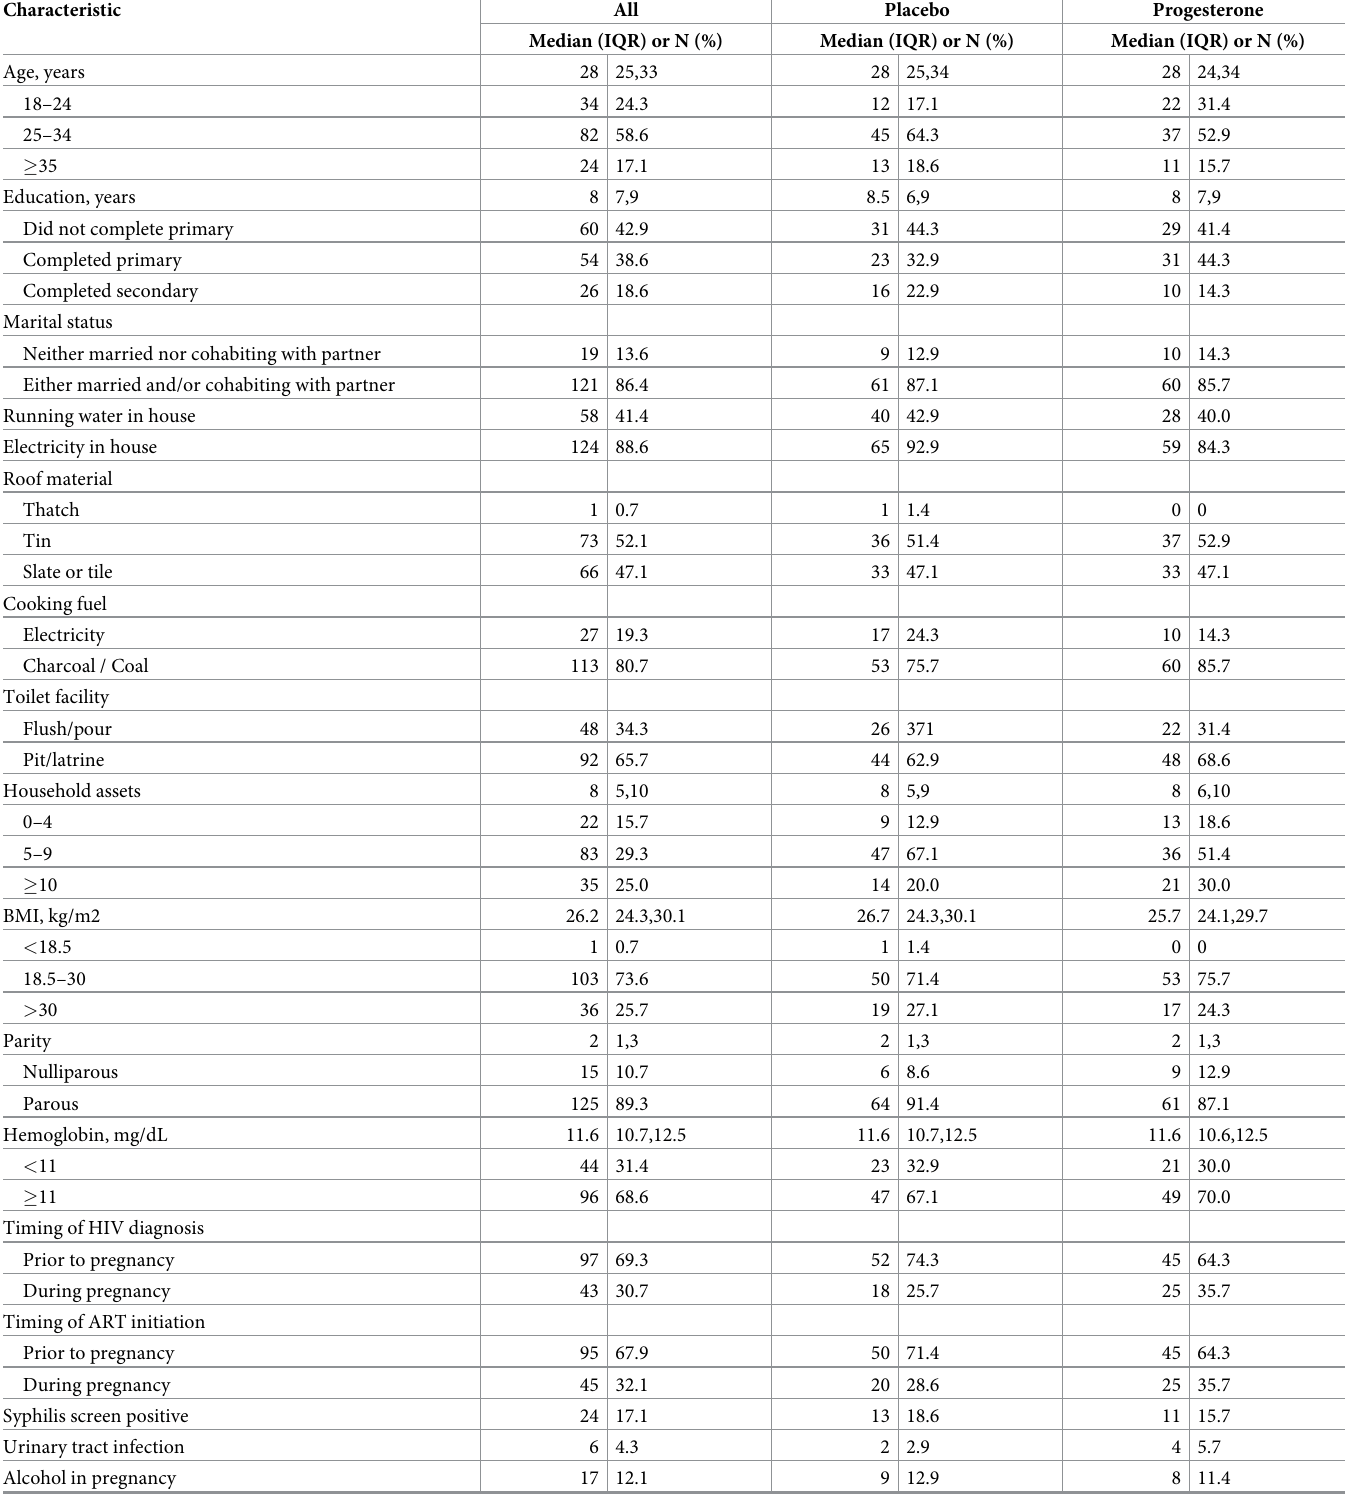
Table 1. Baseline characteristics of randomized participants, N =